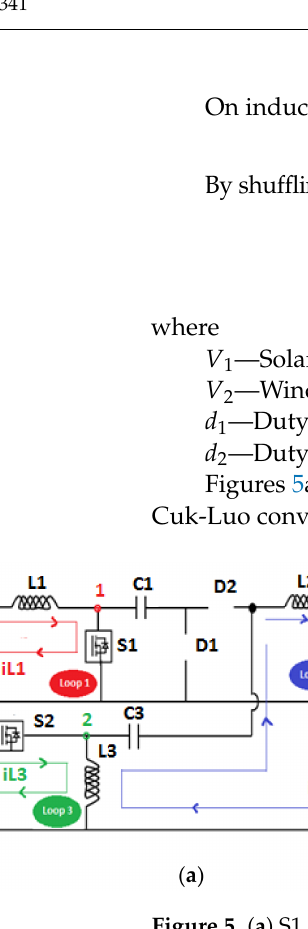
Figure 5. ( a ) S1, S2-ON; ( b ) S1-ON, S2- OFF.